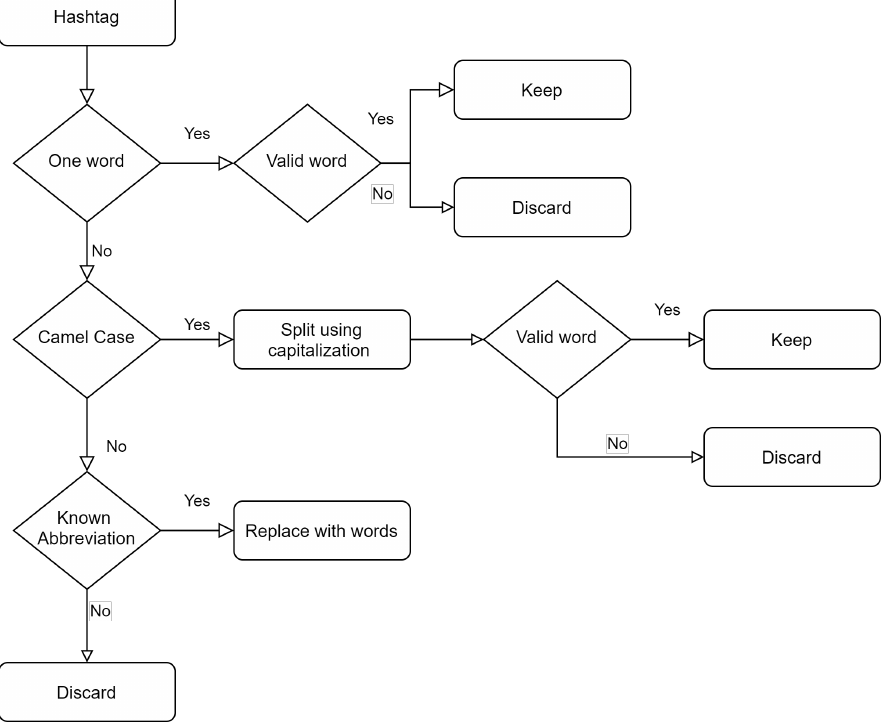
Figure 3. Hashtag processing in